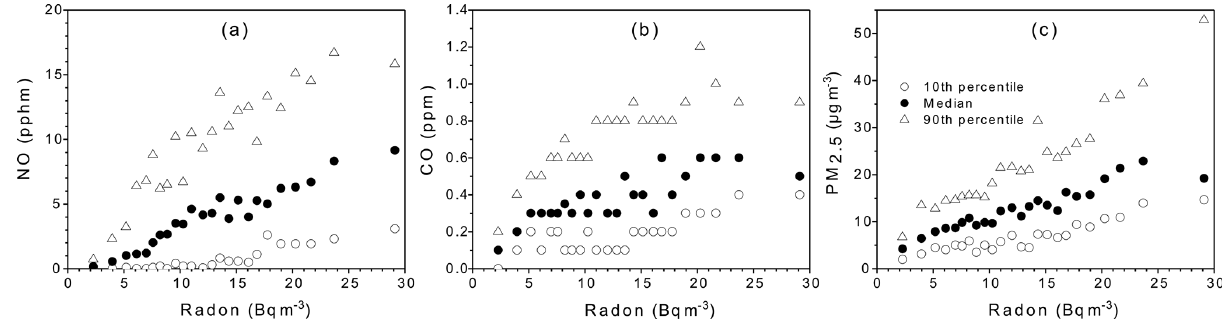
Figure 11. Correlation of bin-mean radon concentration with distributions (10th, 50th, 90th) of (a) NO, (b) CO and (c) PM 2 . 5 , in Autumn (March–May) 2019, between the hours of 18:00 and 08:00AEST (Australian Eastern Standard Time, UTC + 10) each day, for predominantly stable nocturnal conditions (see Chambers et al., 2019a, for details of stability classification method). Each bin (except the last) contained 50 hourly